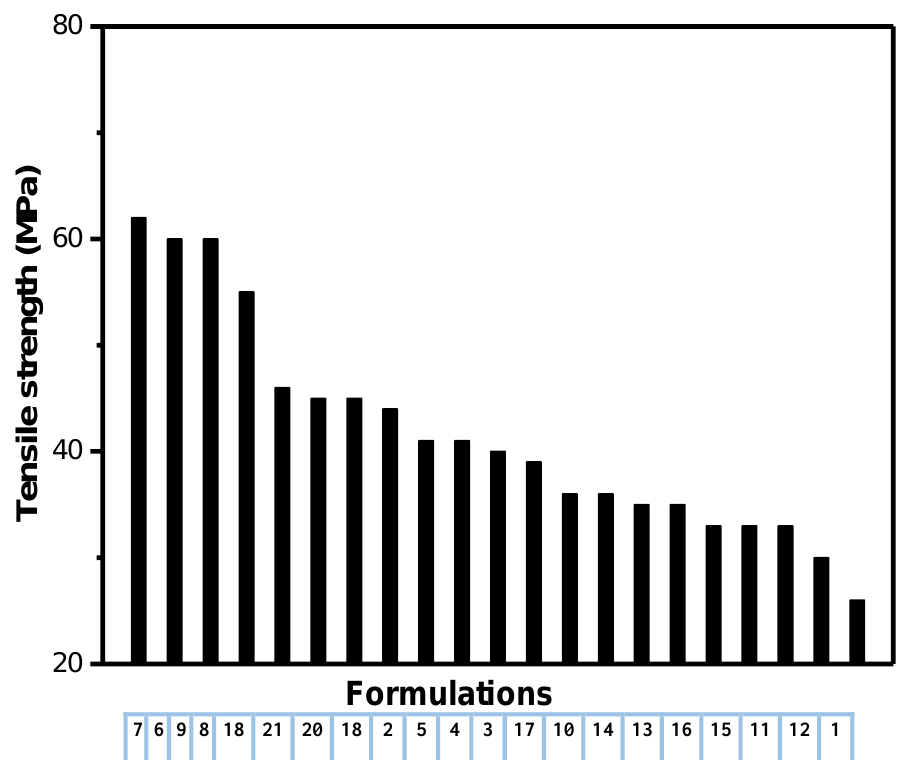
Figure 7. Tensile strength versus formulations in a descending order.